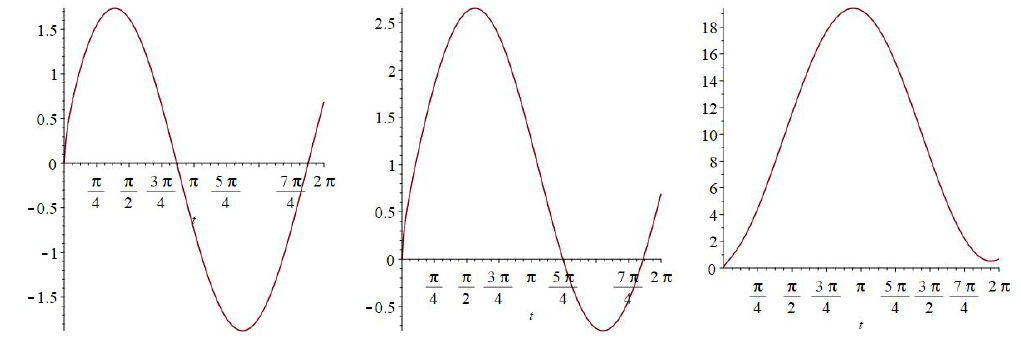
Figure 3. Graph of h ( t ) for λ = 0 ( left ), λ = 1 ( middle ) and λ = 10 ( right